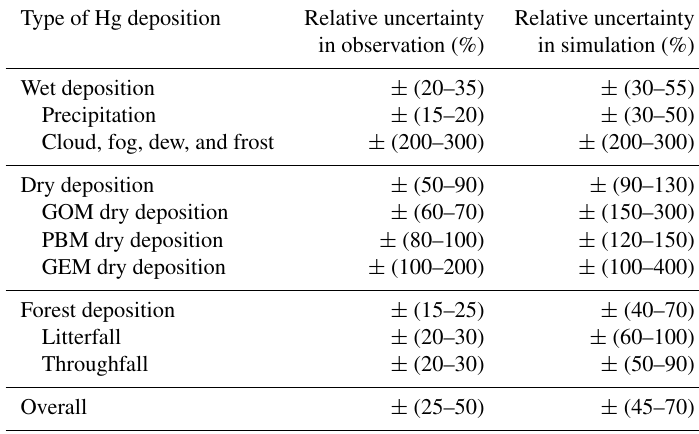
Table 1. Summary of relative uncertainties of different types of Hg deposition to terrestrial